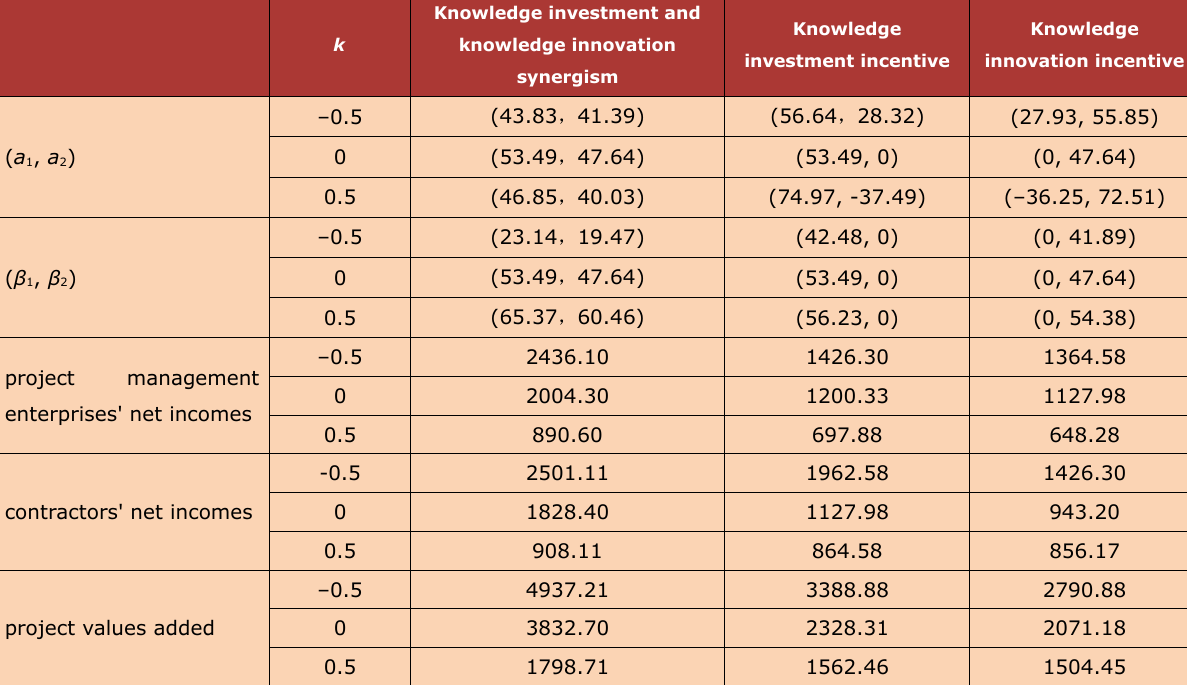
Table 1. The comparison among the results of knowledge investment and knowledge